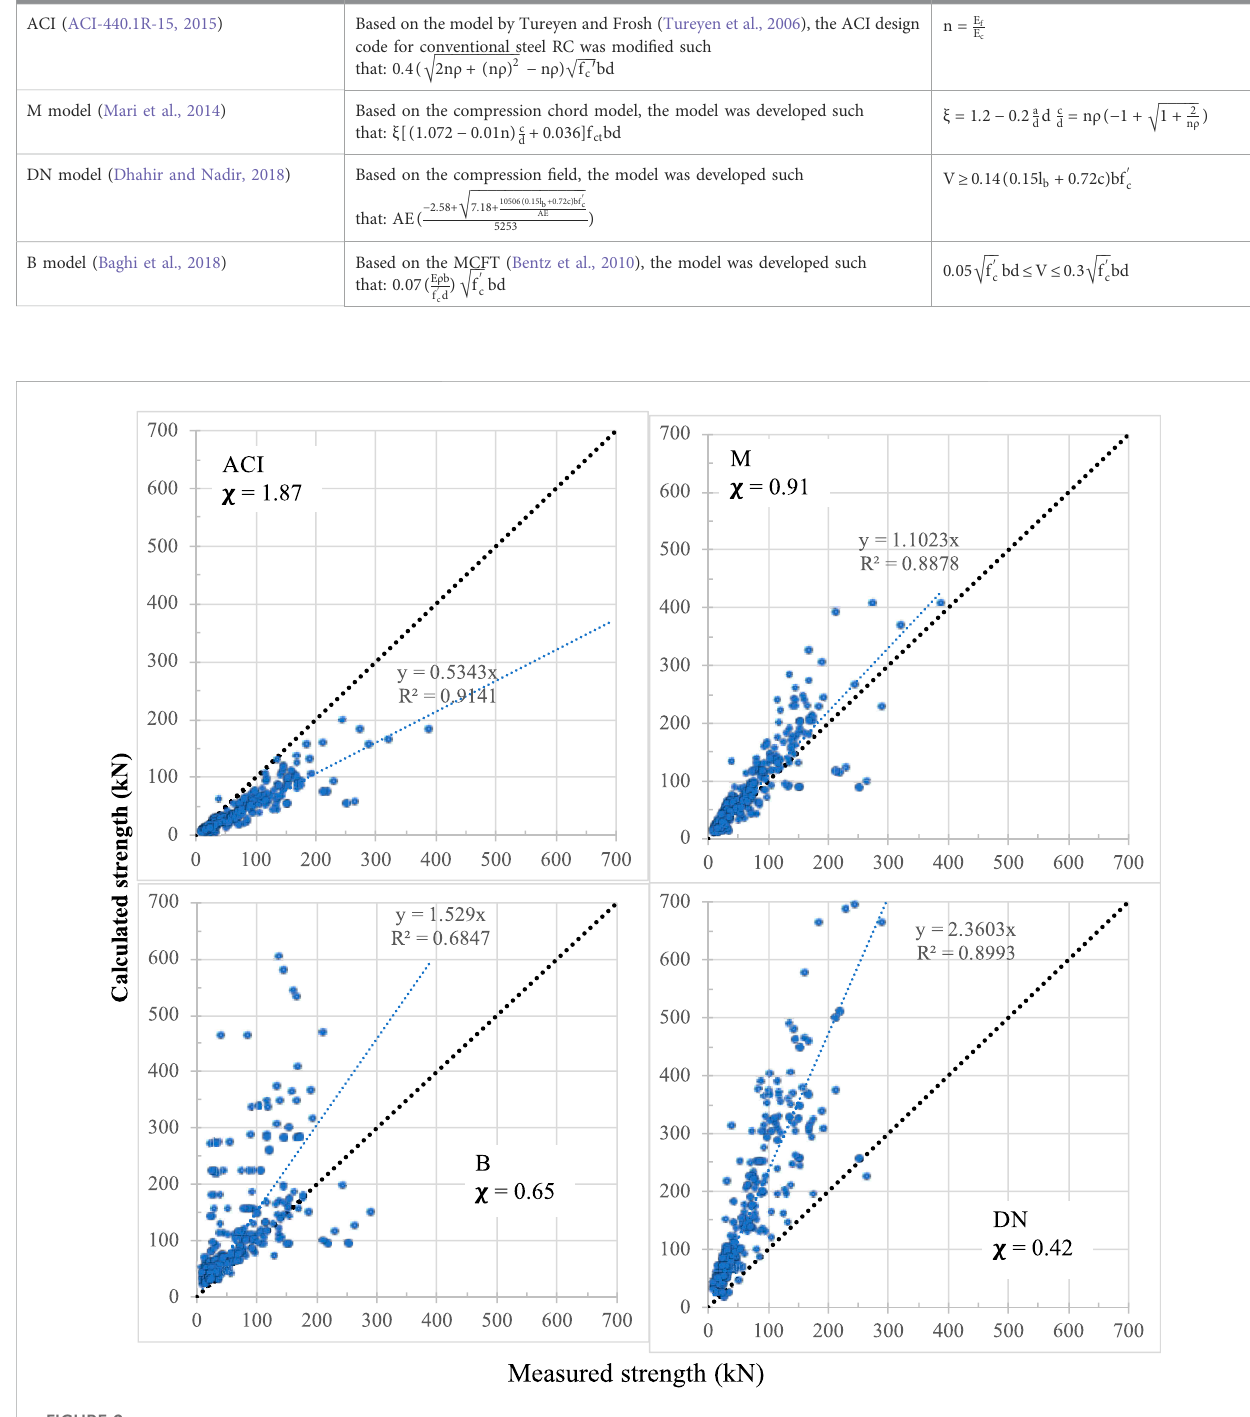
model is the least conservative, with a SR average value of 0.46 and a χ factor value of 0.43. For the other models, the SR average value ranged 0.61 – 0.92 and the χ factor ranged 0.50 – 1.50. For consistency, the coef fi cient of variation ranged 42% – 53%, showing a serious lack